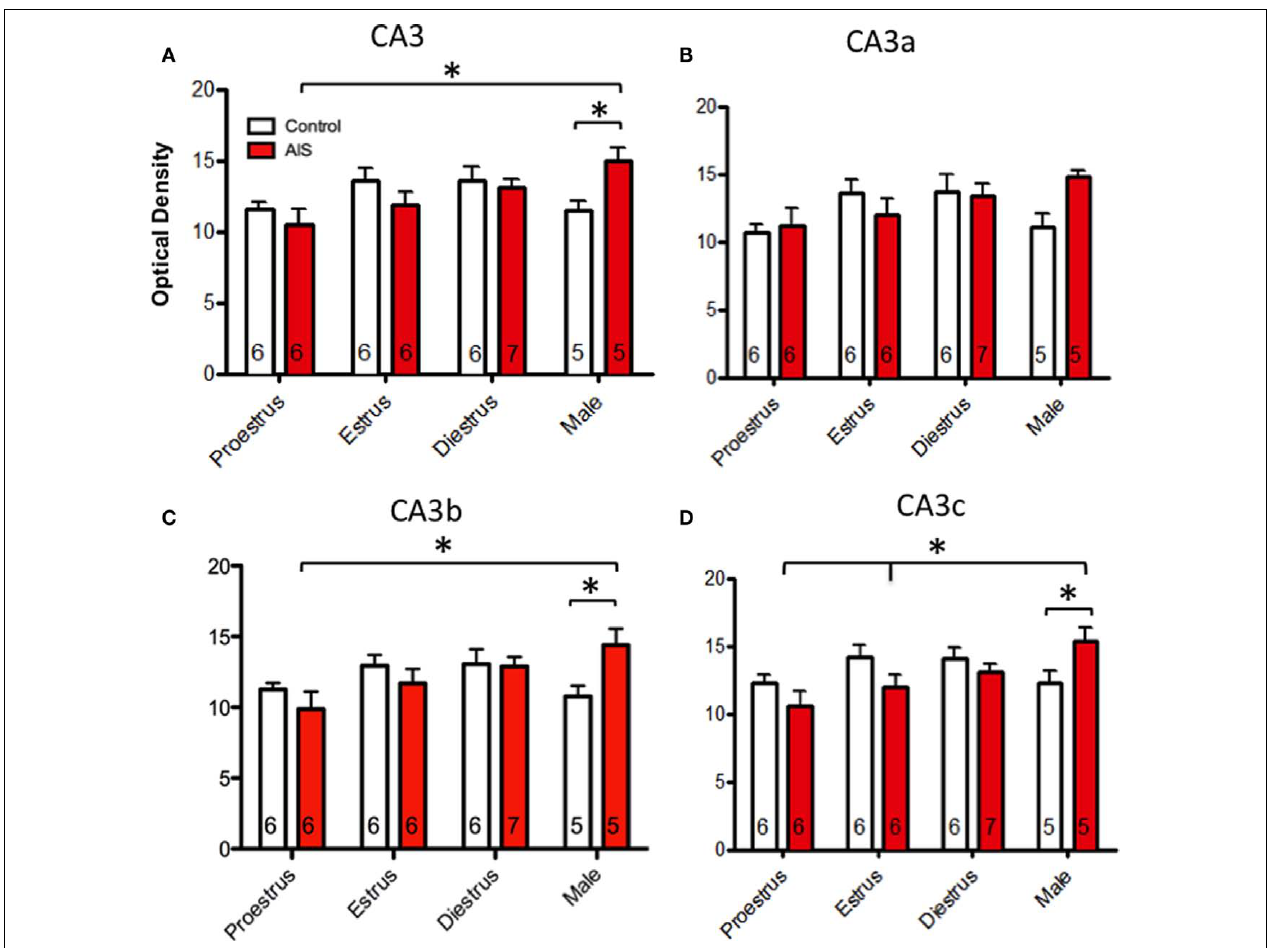
more pMOR-ir than control males and AIS proestrus females (A) .When analyzed as separate regions, AIS significantly increased pMOR-ir in males within the CA3b (C) and CA3c (D) [with a trend ( p = 0.077) in the CA3a (B) ] compared to AIS proestrus females. In CA3c (D) , AIS males also had significantly more pMOR-ir than diestrus females. * p < 0.05, ** p <